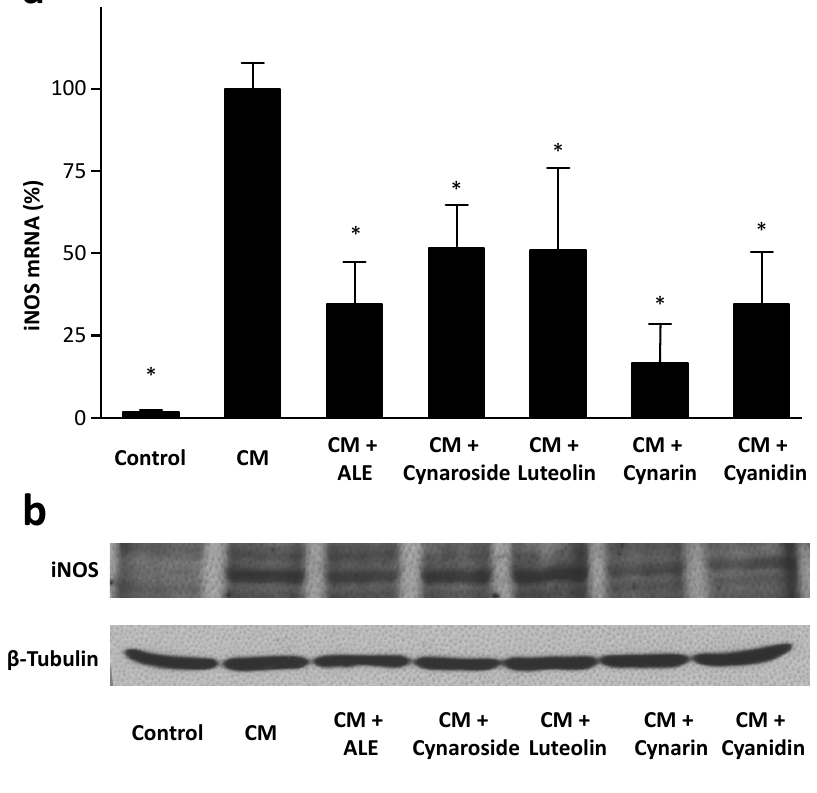
Figure 5. Artichoke compounds downregulate iNOS expression. Human coronary artery smooth muscle cells were treated with the cytokine mixture (CM) or CM in combination with an artichoke leaf extract (ALE, 10 µg/mL) or the artichoke compounds (10 µM each) for 6 h ( a ) or 24 h ( b ). Human iNOS mRNA expression was analyzed with real-time RT-PCR ( a ). * p < 0.05, compared with CM. Protein expression of iNOS was studied with Western blot analyses ( b ). The blots shown are representative of three independent experiments with similar